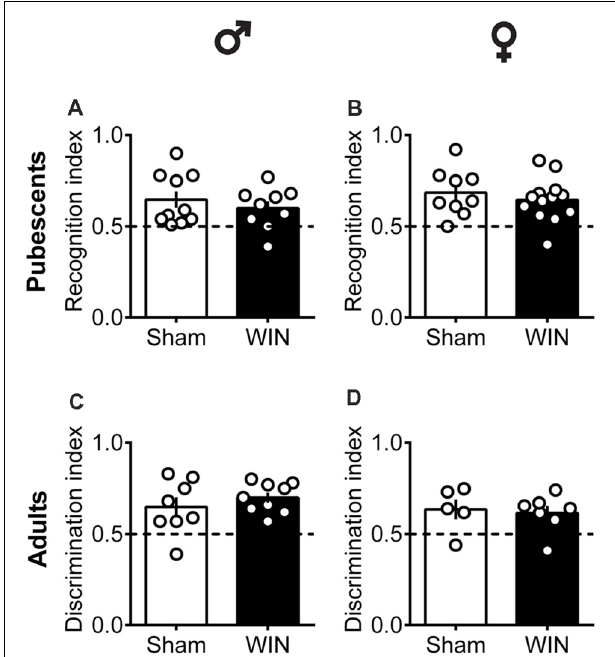
FIGURE 4 | Intact memory discrimination in the novel object recognition test 24 h after single in vivo cannabinoid exposure in both pubescent and adult male and female rats. Animals were tested 24 h after a single exposure to WIN55,212-2 (WIN, 2 mg/kg, s.c.). Recognition index between the novel and familiar objects were similar in male (A) and female (B) WIN-treated pubescent rats compared to their respective Sham groups. Similarly, no differences were observed in recognition index in male (C) and female (D) adult rats treated with WIN. Data represent mean ± SEM. Scatter dot plot represents one animal. Mann-Whitney U -test. TABLE 1 | Statistical report for rearing and grooming events in pubescent and adult rats from both sexes tested 24 h after a single in vivo exposure to WIN55,212-2 (2 mg/kg,